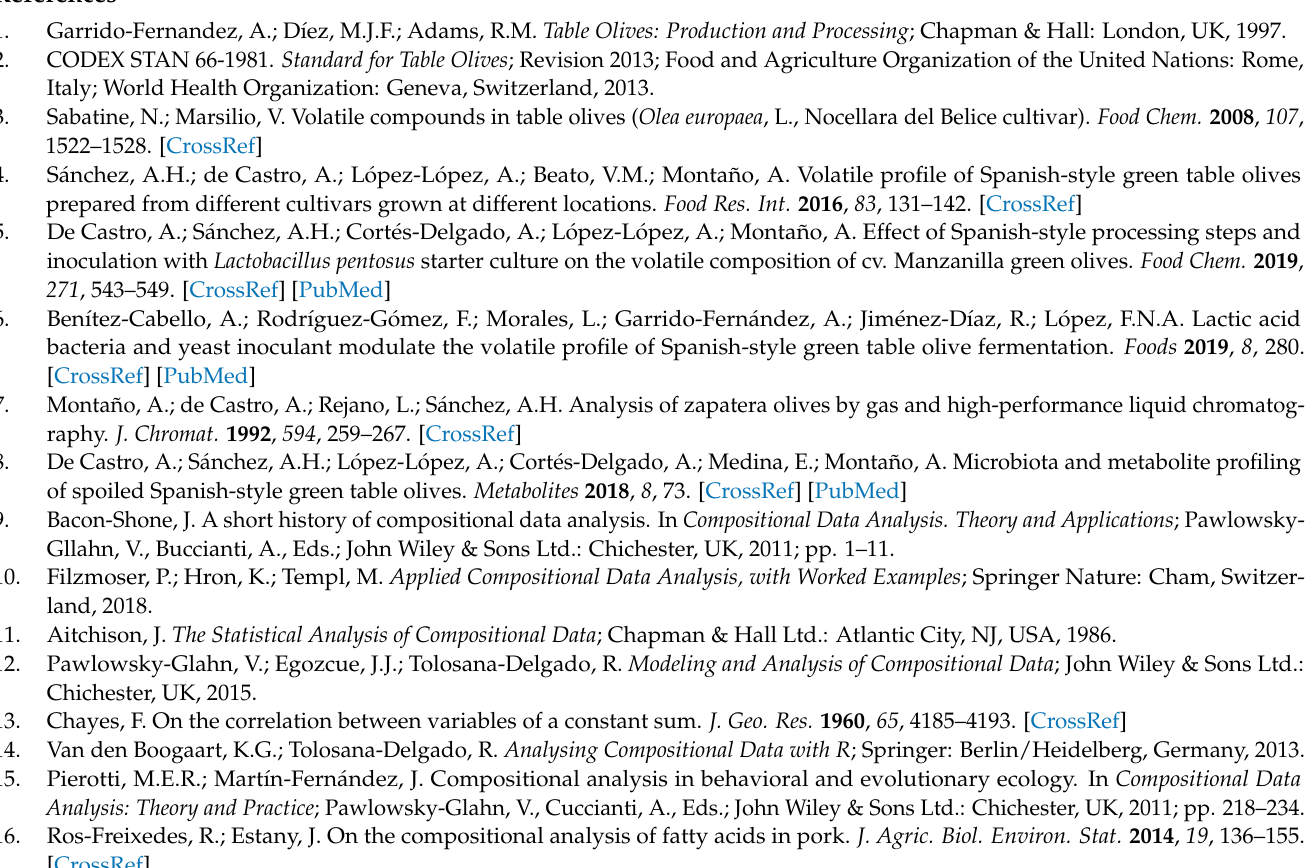
Spanish-style Manzanilla table olive samples from two industries, Table S2: Significant contributions of spoiled and normal samples to the ANOVA model of each clr transformed VOC identified in them, Table S3: Log-ratio variances and clr variances of the VOCs in butyric, sulfidic, putrid, and normal Spanish-style Manzanilla table olives, regardless of fermentation condition, Table S4: Summary of the VOCs association with the butyric, sulfidic, putrid, and normal Spanish-style Manzanilla table olives, according to the statistical techniques